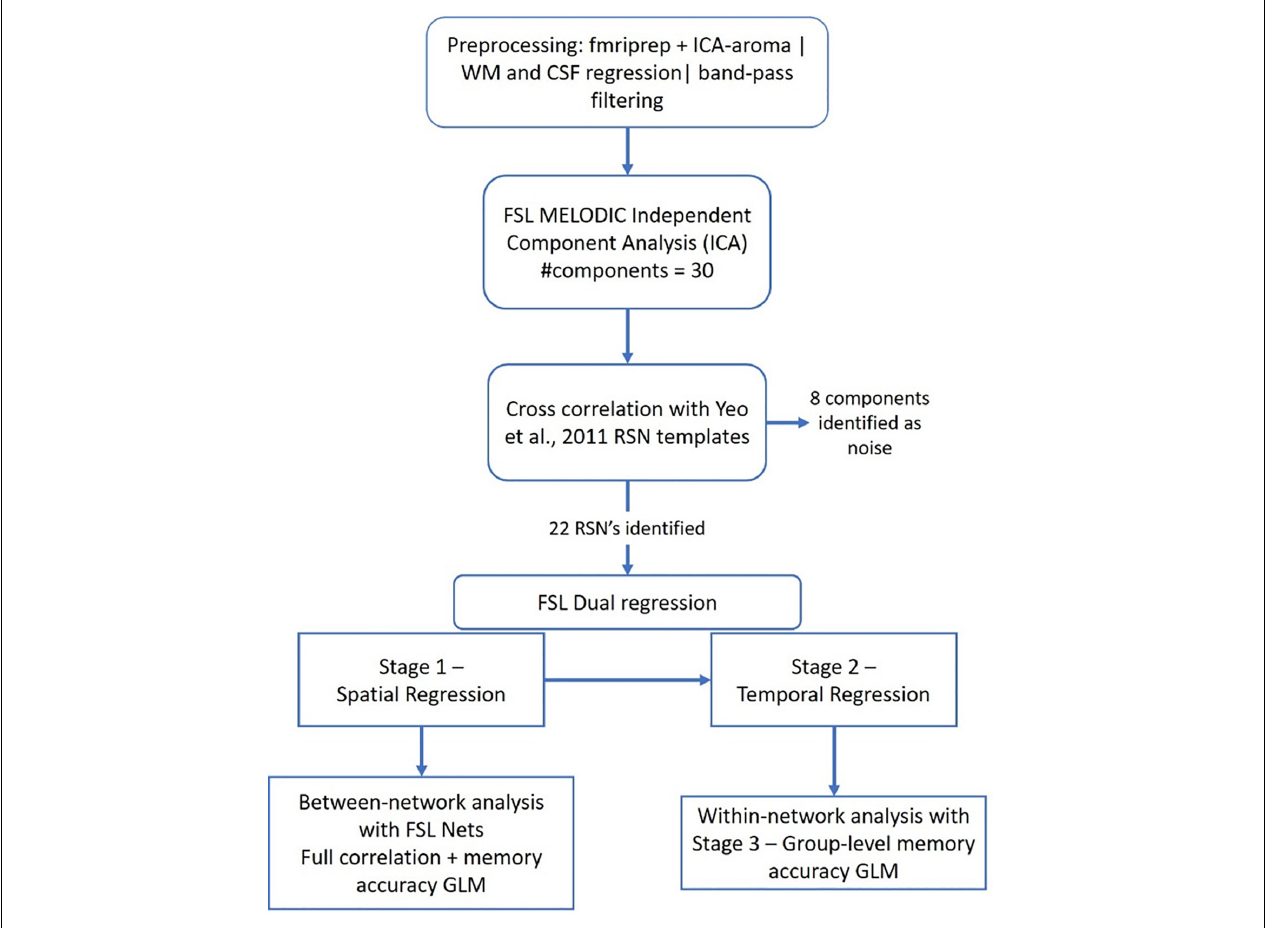
FIGURE 2 | Processing pipeline for the resting state data